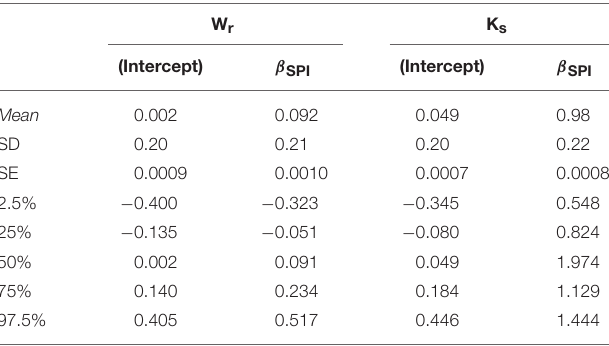
Marginal posterior distribution of mean, standard deviation, and quantiles for α (intercept) and β SPI . SPI, Standardized Precipitation Index. Trace and density plots are on Supplementary Figures S1,